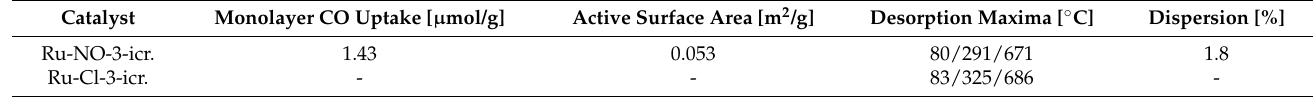
Table 6. Data obtained from the temperature-programmed desorption of